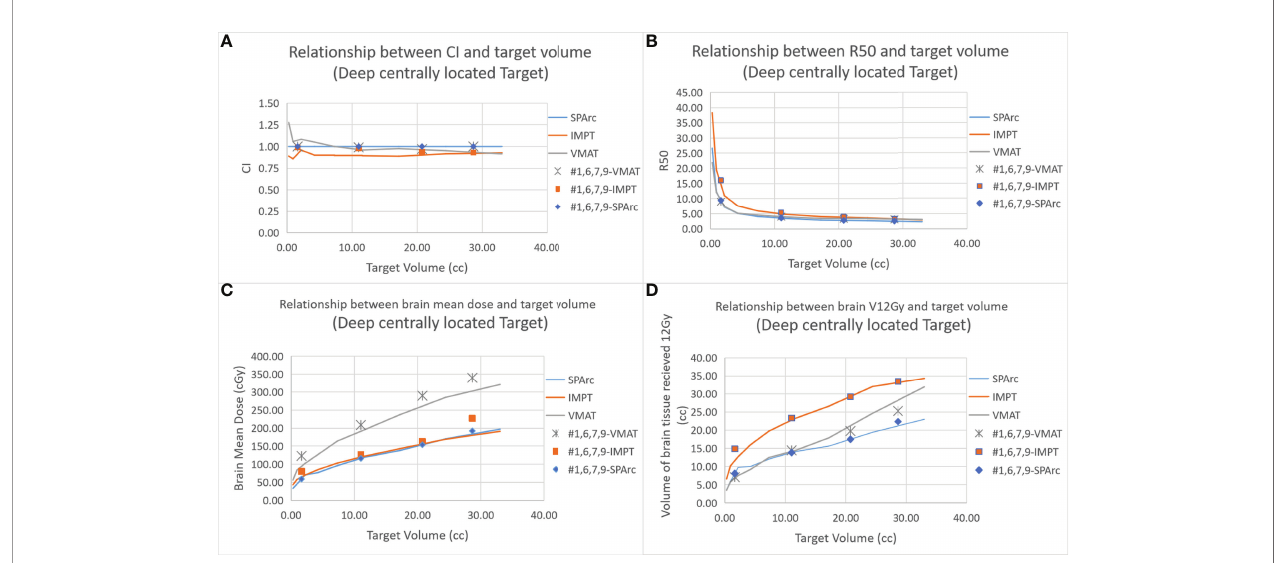
FIGURE 3 | Dosimetric metrics among three planning groups: SPArc, VMAT, and IMPT at deep central (A – D) of different target sizes. Dots, squares, and stars are the dosimetric metrics extracted from four clinical validation cases normalized to SPArc plan ( Table 2